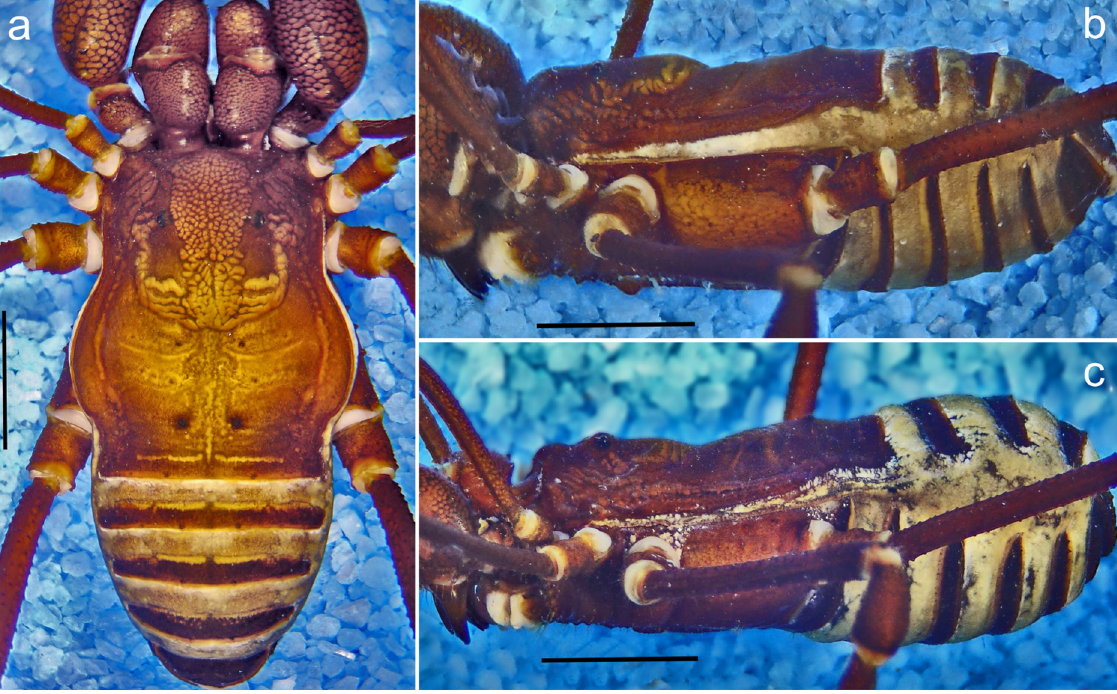
b . Habitus, lateral view. c . Paratype, ♀ (ICN-AO-1436.1), habitus, lateral view. Scale bars = 5 mm.